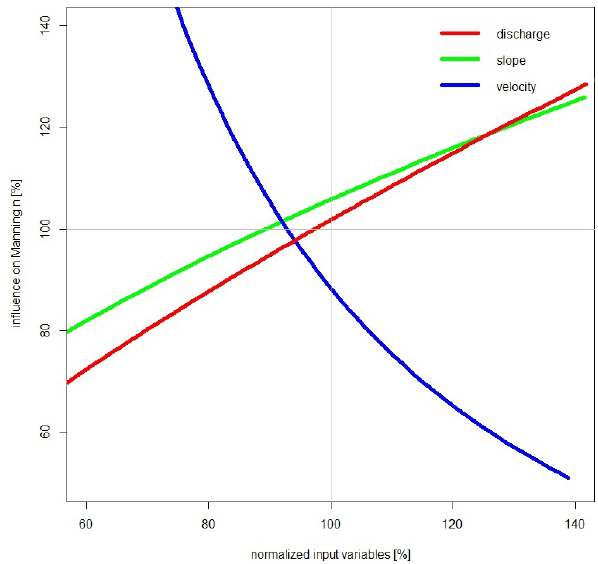
Figure 8. Sensitivity of three normalized input parameters and their influence on Manning’s n .